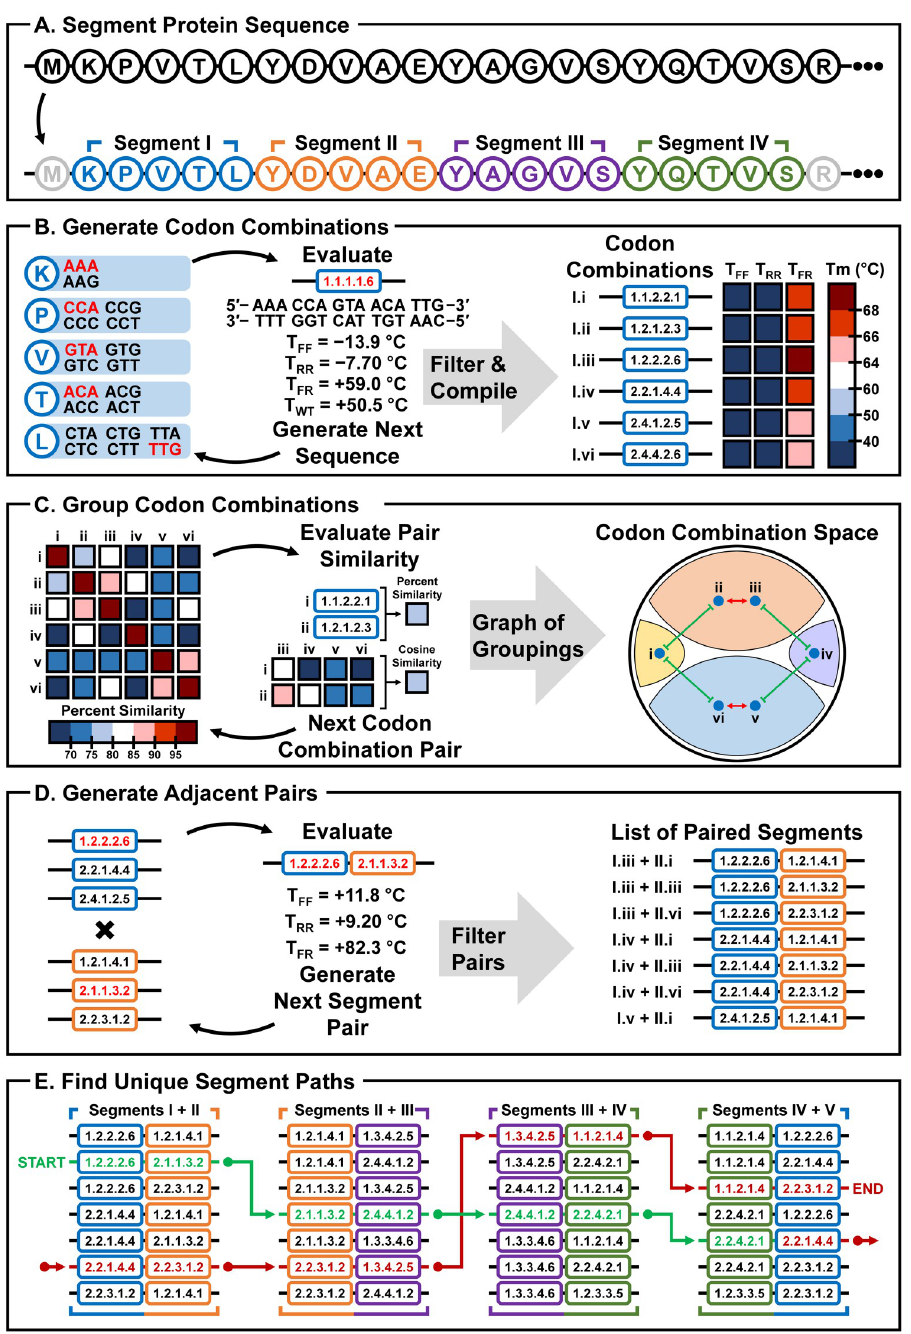
Fig 1. Overview of the TR DNA sequence redesign strategy implemented in TReSR. The design strategy presented in this study is schematically outlined for the construction of a TR containing two identical 20 amino acid segments from the N-terminus of the LacI repressor. (A) The TReSR protocol is initiated by dissection of the 20-amino acid target sequence into contiguous 5-residue segments (labelled with upper-case roman numerals) for DNA sequence redesign. (B) This is followed by the generation of a sequence list (with individual sequence entries labelled with lower- case roman numerals) constructed from combinations of synonymous codons that encode the amino acid sequence for each segment. An example codon combination encoding the amino acid sequence for segment I is shown that uses the codons highlighted in red. The label for this codon combination is given by a number for each amino acid that corresponds to the list position for the codon used (e.g., for the sequence shown, the first codon is used for all amino acids except for the last one which used the 6th codon in the list). Melting temperatures (Tm) of all